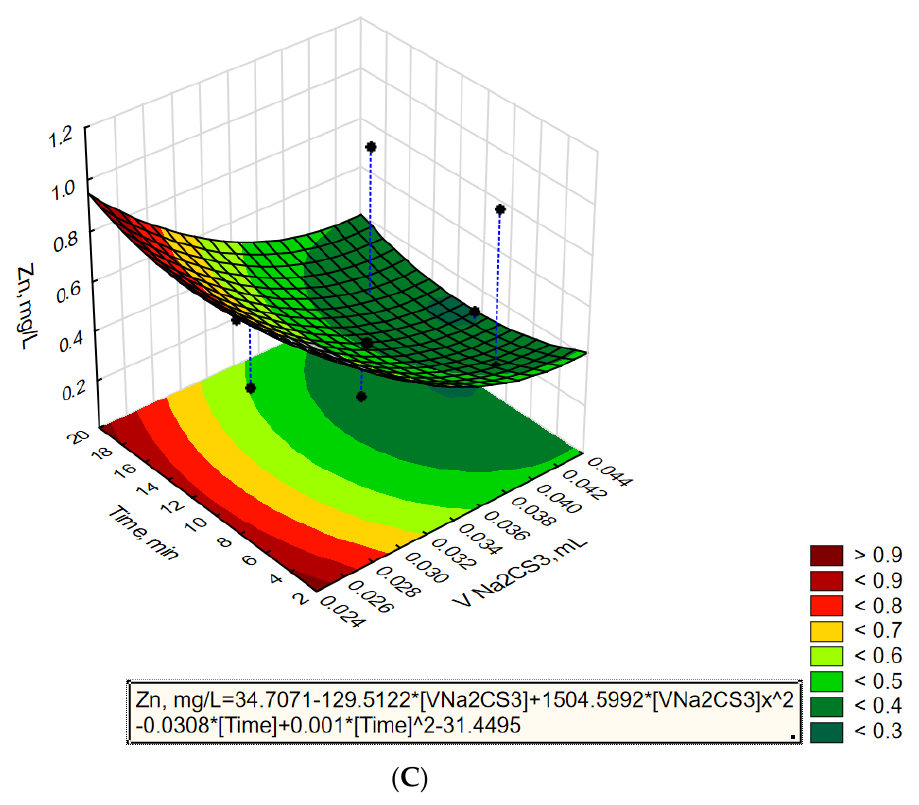
Figure 4. Response surface plots for Zn, mg/L with respect to pH and V Na 2 CS 3 dose, for constant time = 10 min ( A ), pH and time (min) for constant V Na 2 CS 3 dose = 0.035 mL/L ( B ), and V Na 2 CS 3 dose and time (min) for constant pH = 10 ( C ).